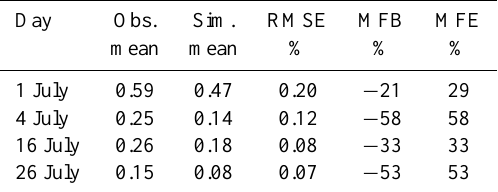
Table 3. Statistics (see Appendix A) of the simulation results for the AERONET network for different lidar measurement days. Day Obs.